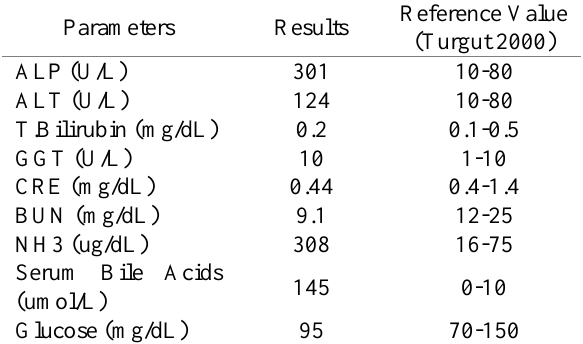
Table 1: Laboratory Results of the dog with Portosystemic shunt